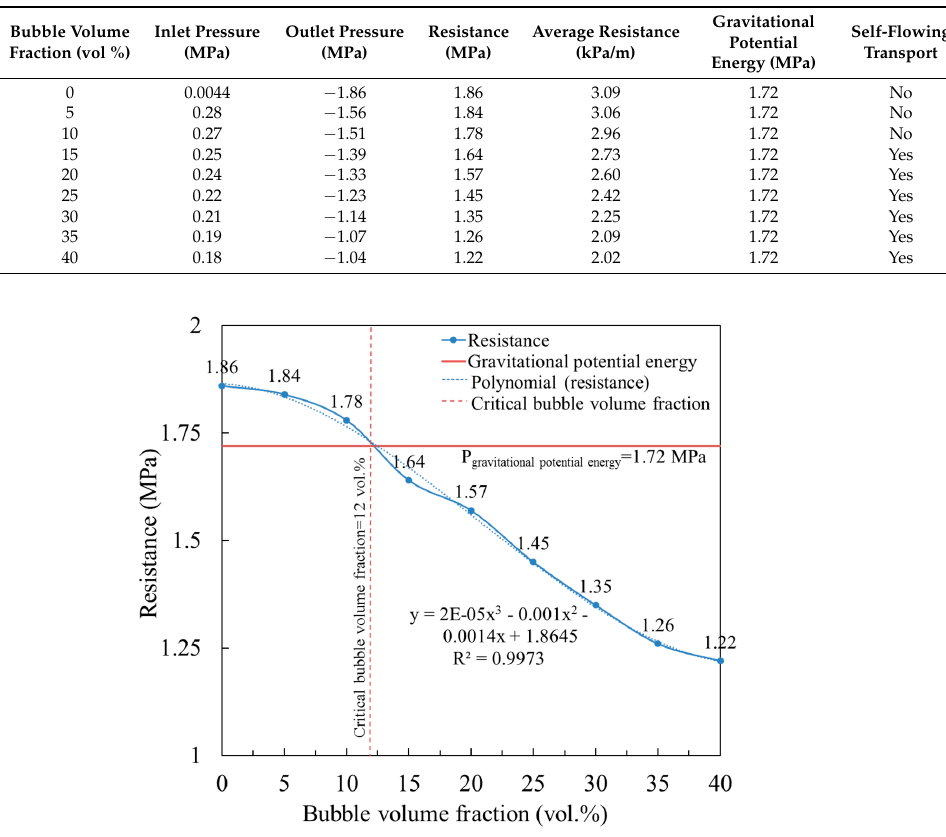
Figure 10. Relationship between total resistance and bubble volume fraction.